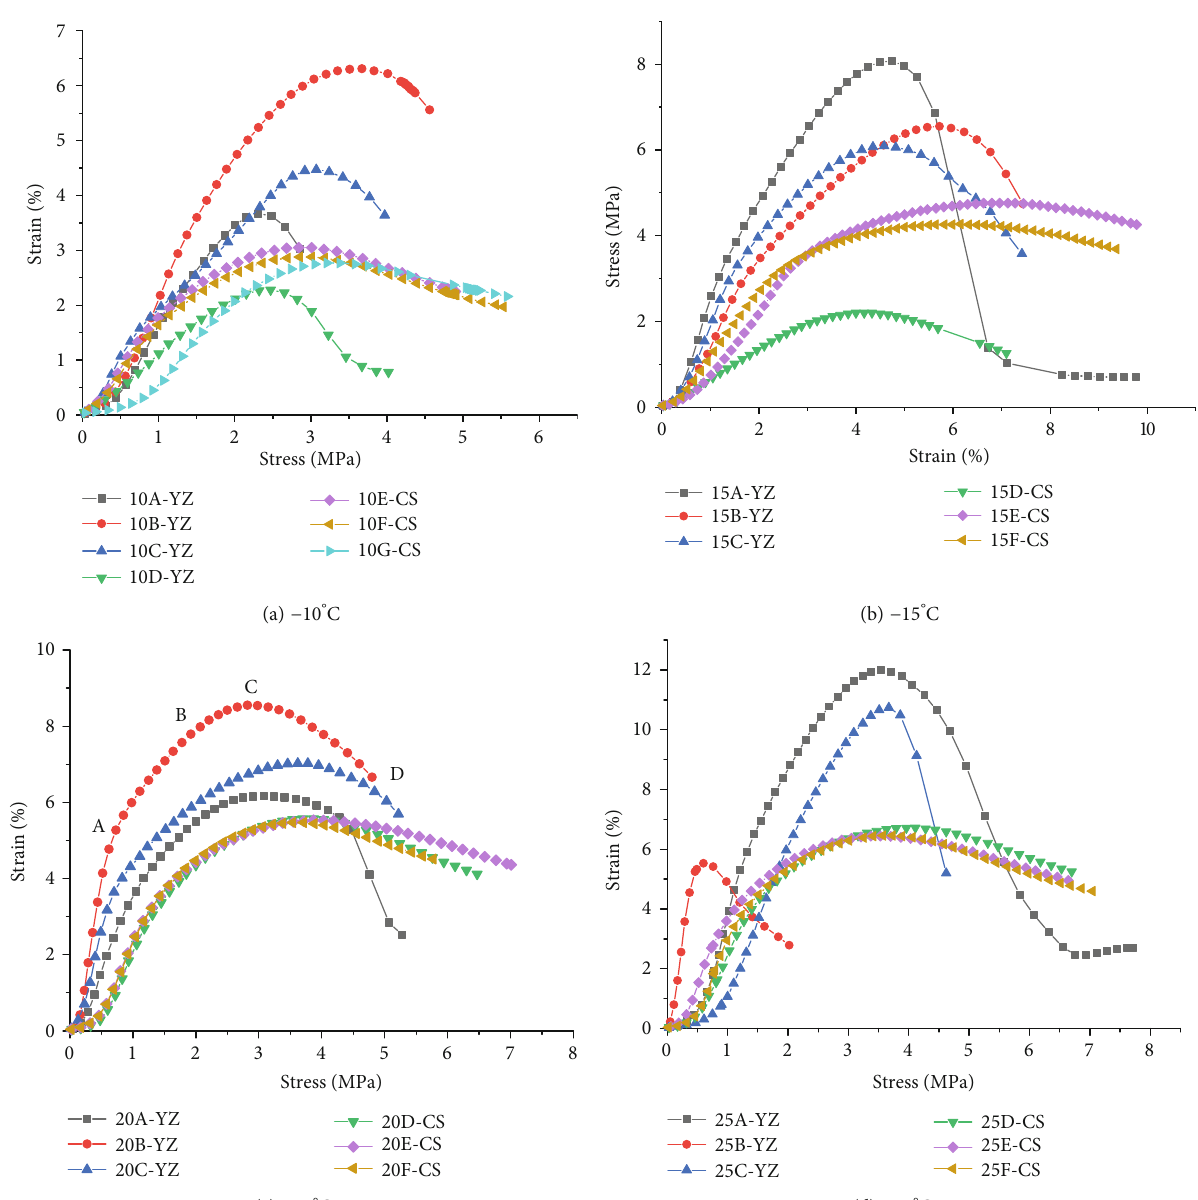
Figure 4: Stress – strain curves of the undisturbed permafrost and remolded permafrost in the A2